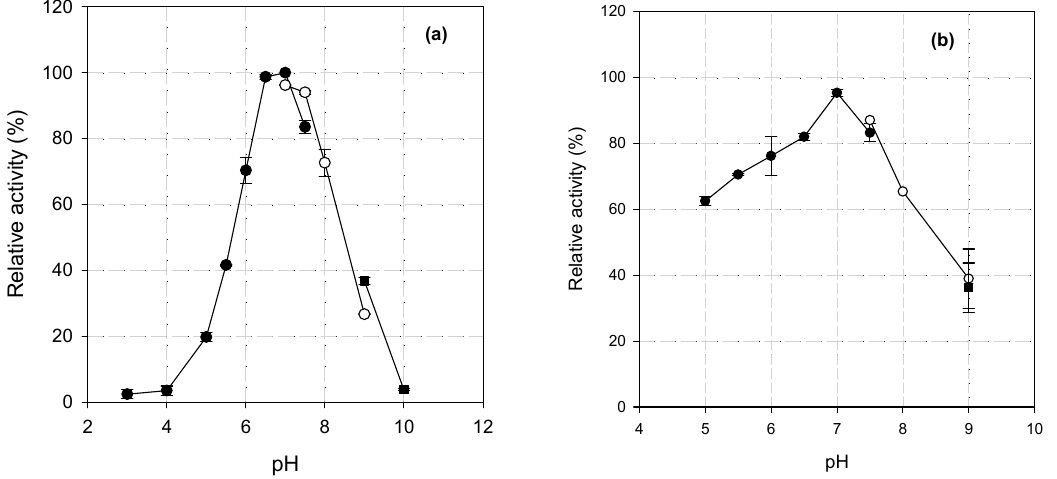
Figure 2. The effect of pH on the ( a ) activity and ( b ) stability of BsXyn10. Symbols : ( • ) citrate-phosphate buffer (2.5–7.5), ( ) Tris-HCl buffer (7.5–9.0), ( ) glycine/NaOH (9.0–10.0). The stability of BsXyn10 was studied at different pH and the results are presented in Figure 2b. The enzyme retained more than 60% of its initial activity at pH 5.0–8.0 after 24 h incubation at 4 ◦ C, while at pH = 9.0, the residual activity dropped to 39%. Similar results were obtained for xylanases of different bacterial species that were stable in wide pH ranges including acidic, neutral, and alkaline conditions (Table 1). For example, Xyn10 retained more than 60% of its initial activity at pH 5.4–10.6 after incubation at 4 ◦ C for 16 h [8]. rXynAHJ2 of Bacillus sp. HJ2 [10] and Xyn30Y5 [13] exhibited over 50% and 80% residual activity, respectively, when incubated at a pH range of 6.0–10.0, but at different incubation conditions (Table 1).